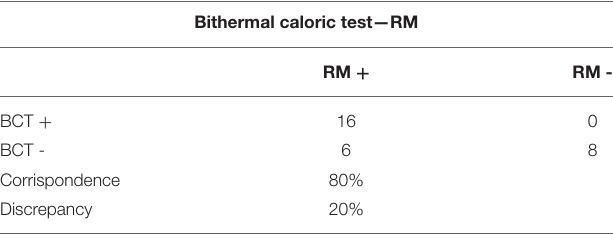
TABLE 6 | Bithermal Caloric Test: Ratio between positive and negative patients on MRI and patients with a preponderance > 20% ( p = 0.004).